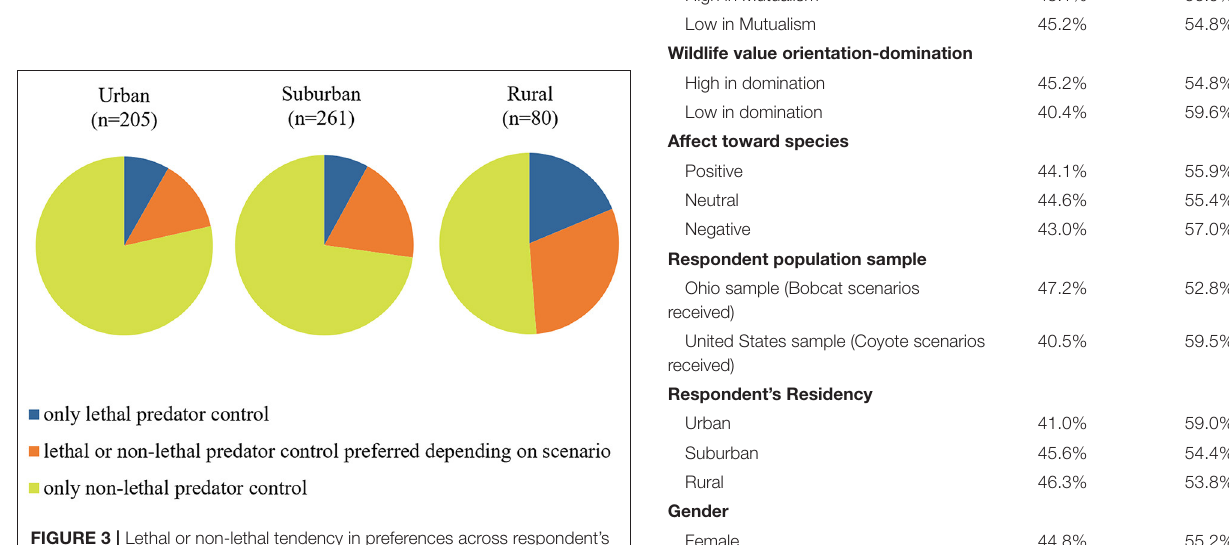
FIGURE 3 | Lethal or non-lethal tendency in preferences across respondent’s reported level of urbanization.